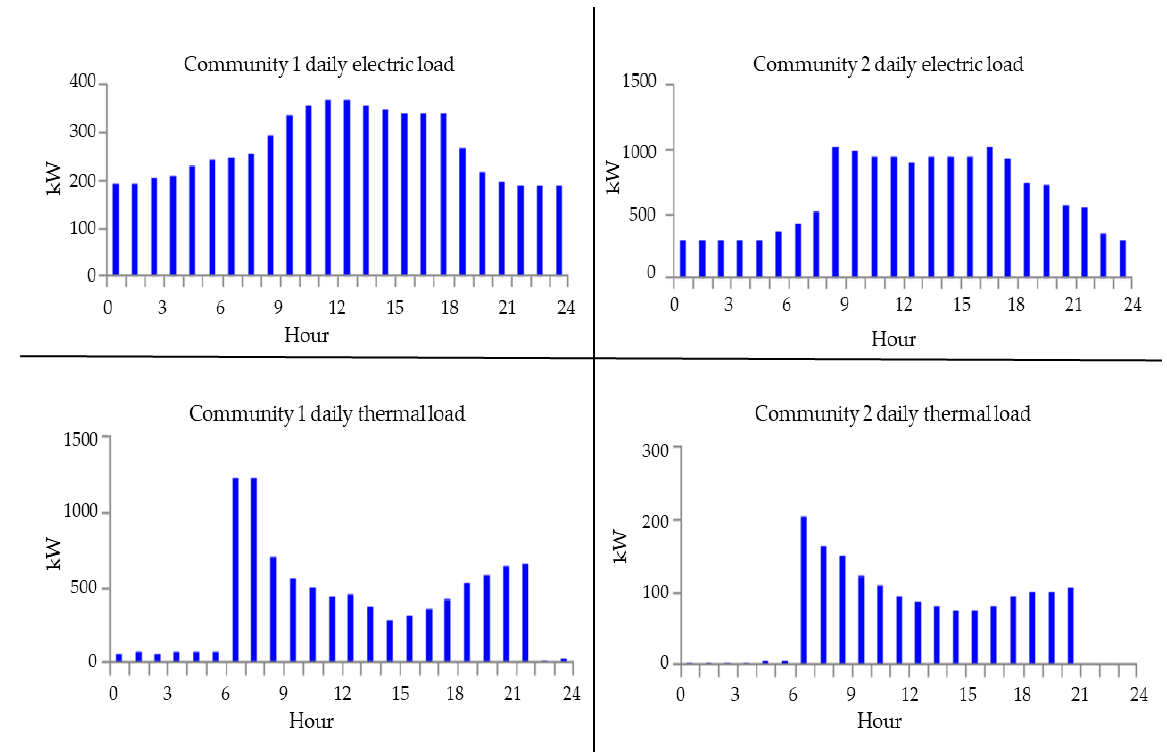
Figure 4. Daily electrical and thermal energy demand of distributed communities.